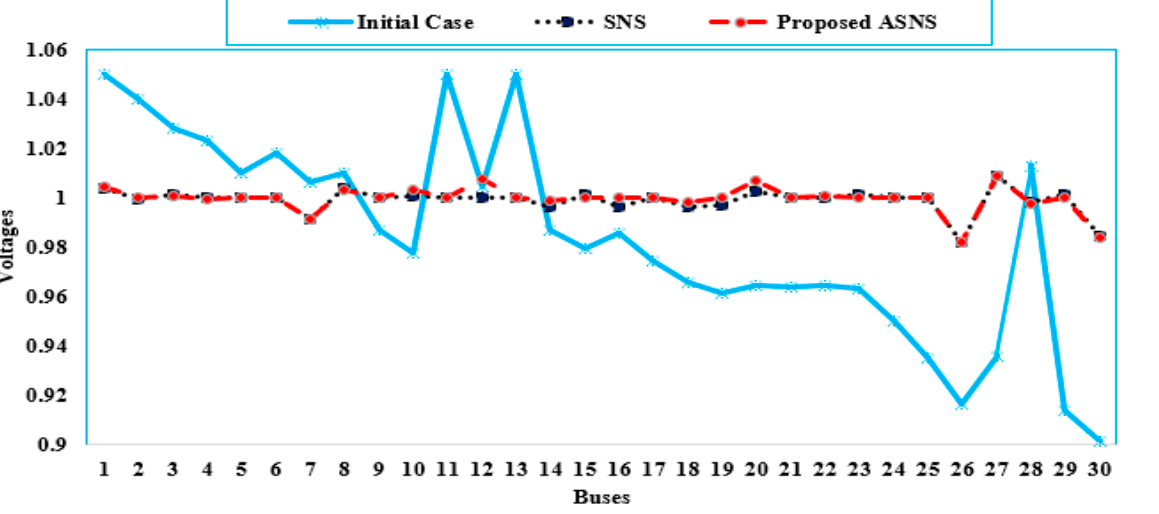
Figure 6. Voltage Pro fi le of the proposed ASNS and SNS for Case 2 of the IEEE 30-bus grid.